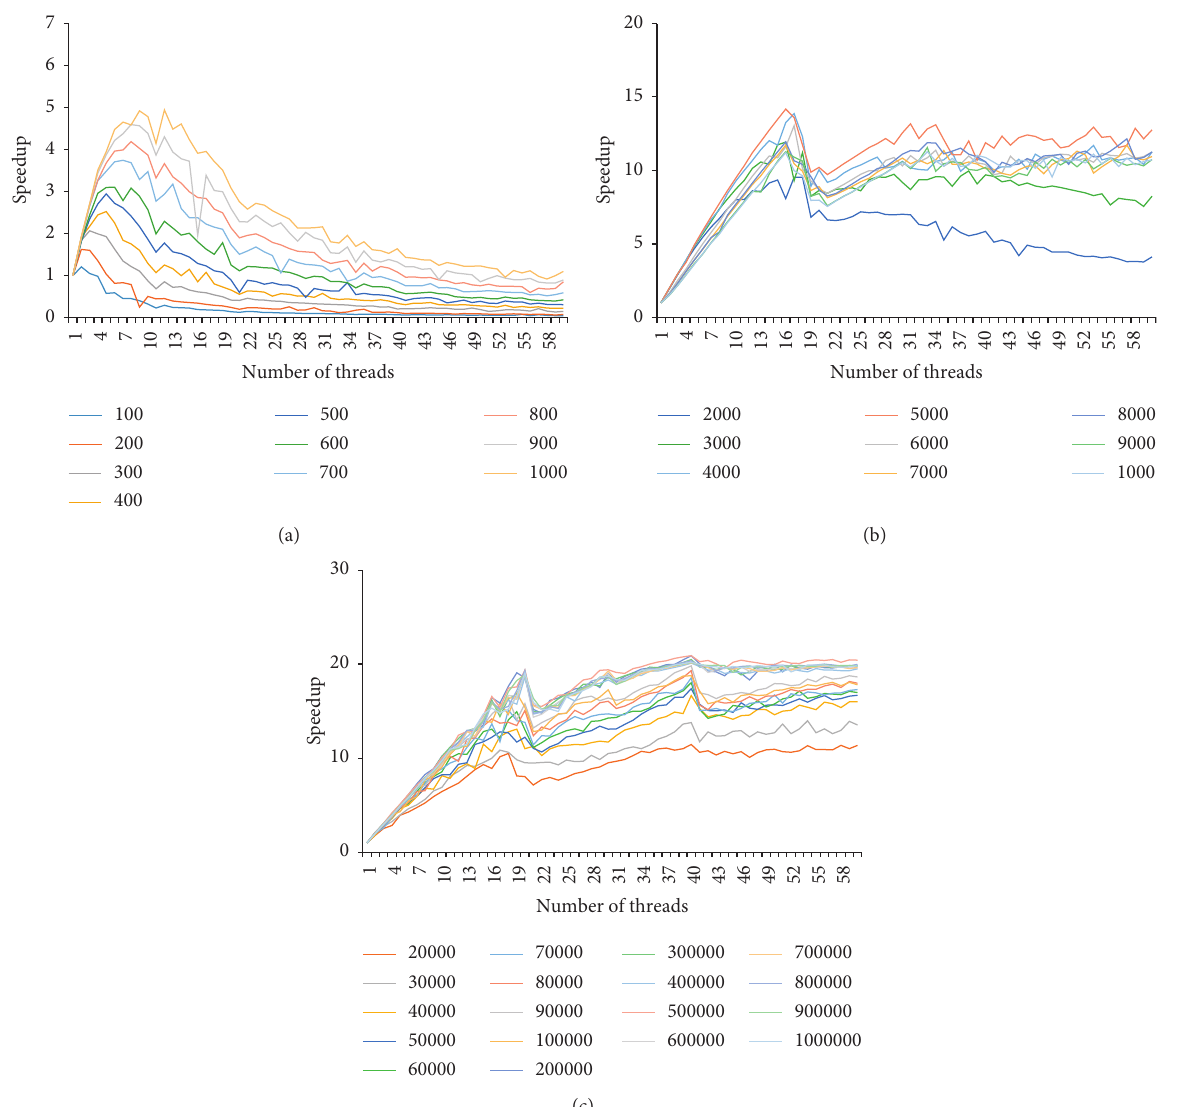
Figure 2: Performance with different number of threads. (a) Problem size from 100 to 1000, (b) problem size from 2000 to 10000, and (c) problem size from 20000 to